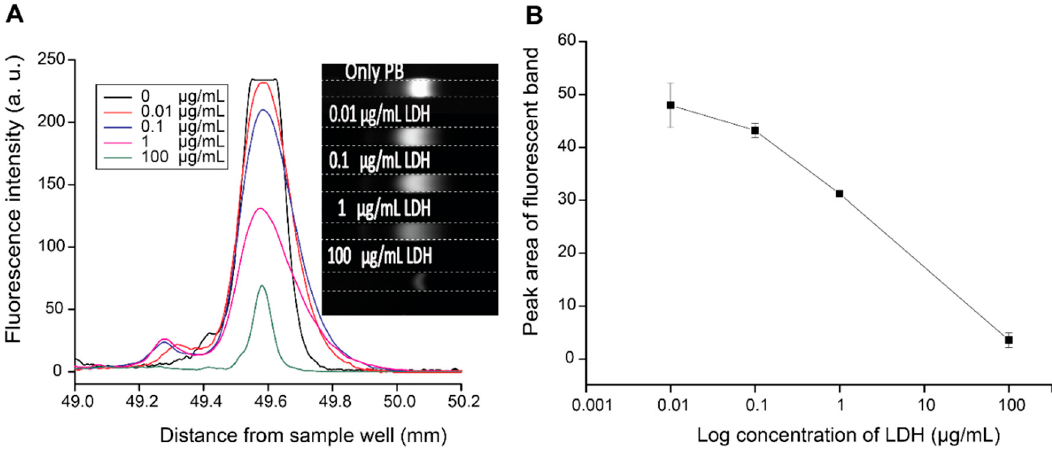
Figure 4. The indirect measurement of lactose dehydrogenase (LDH) using ITP. A series of LDH concentrations (0.01, 0.1, 1, and 100 µ g / mL) were prepared and conjugated with PB. In total, 200 mM Tris-HCl for LE and 40 mM borate bu ff er for TE were used under 138 V / cm. ( A ) The intensity profile of the PB band during the ITP process with various LDH concentrations. ( B ) The peak areas of the PB bands are plotted with the log of LDH concentration.